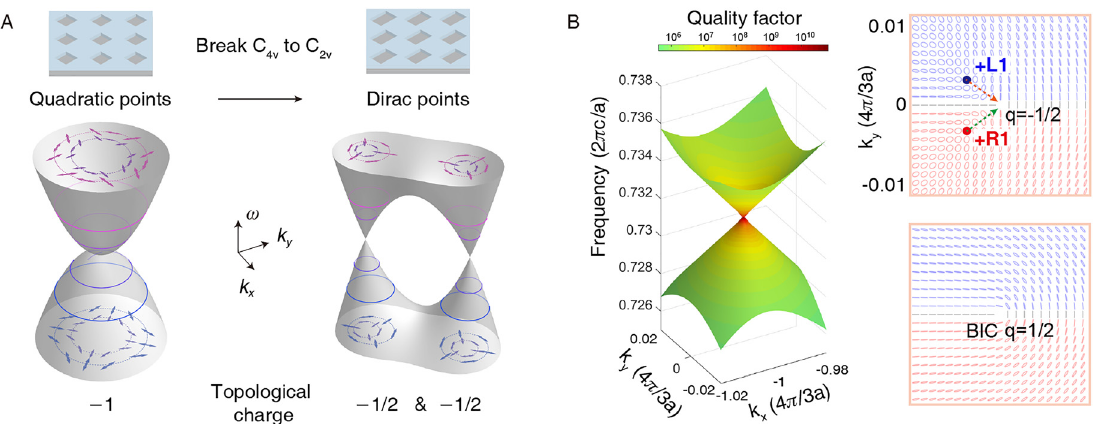
Figure 4: (A) Schematic views of polarization singularities at band degeneracies. A quadratic degeneracy will have a radiative integer-index V-point, while a linear degeneracy (Dirac point) will have a radiative half-integer-index V-point. A quadratic degeneracy is protected by rotational symmetry higher than two folds, and by breaking the symmetry of a plasmonic crystal from C 4 v to C 2 v (see insets), it will split into two linear degeneracies, and the corresponding V-point would split as well. (B) An example of naturally existing C-points near a Dirac point at the corner of a hexagonal-lattice photonic crystal slab. Their mergence with the radiative V-point at the Dirac point would result in a non-radiative V-point, i.e. a BIC. Left: the quality factor map of the Dirac degeneracy. Right: the polarization map on the upper band of the degeneracy, before and after the mergence. (A) is adapted from [86] and (B) is adapted from